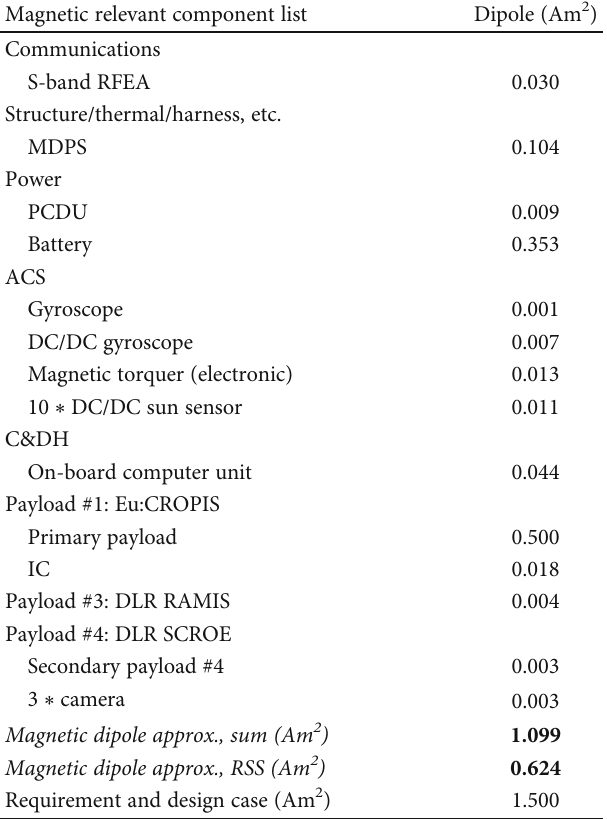
Table 1: Magnetic